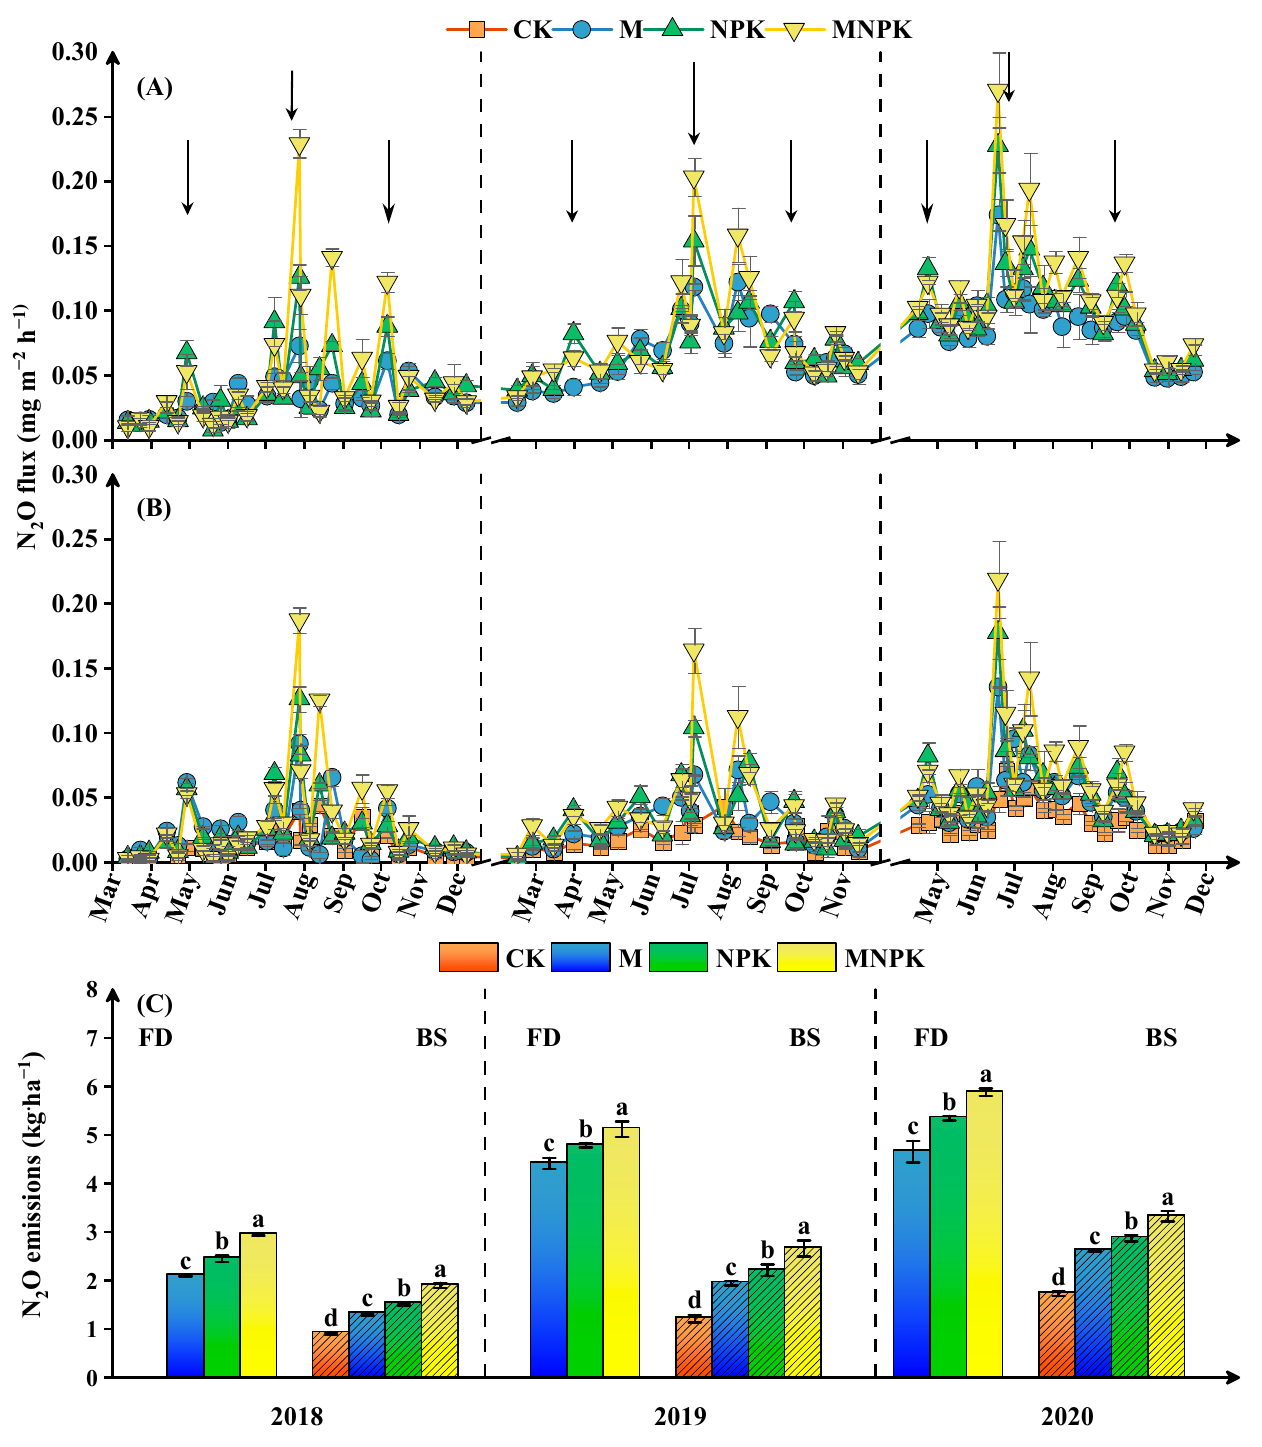
Figure 7. Seasonal variations in N 2 O flux across the sampling sites and treatments. ( A ) FD: Fertilizer ditches, ( B ) BS: bare soil sites, ( C ) annual cumulative N 2 O emissions from different treatments. CK: control, M: organic manure, NPK: chemical fertilizer, MNPK: chemical fertilizer combined with or‑ ganic manure. The data points indicate the means of the three replicates, the error bars indicate the standard error ( ± SE), and the black arrows indicate nitrogen fertilizer applications. The difference in lowercase letters indicate significant differences between the treatments ( p < 0.05).